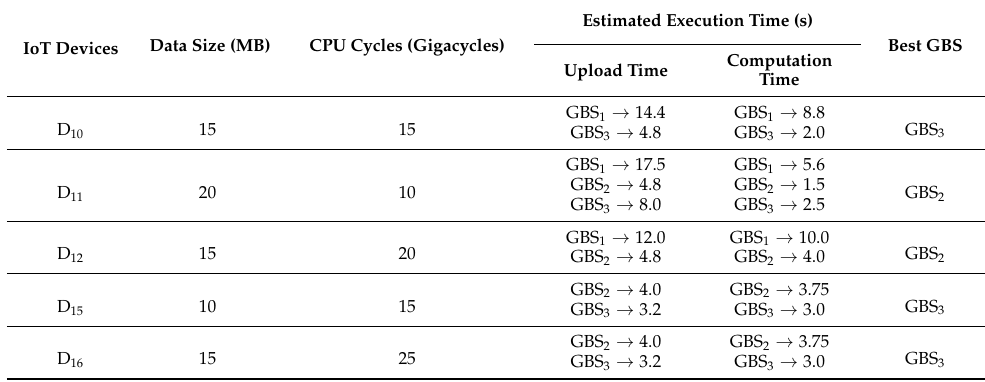
Figure 2. Snapshot of IoT devices distribution. Table 2. Proposed algorithm